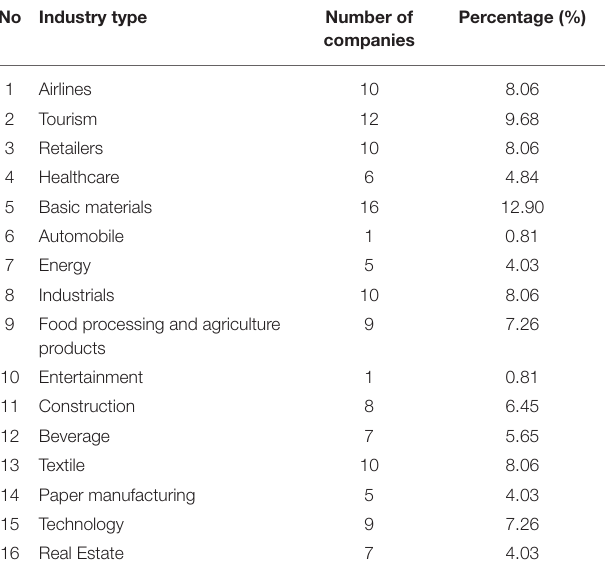
TABLE 1 | The general profile of samples by